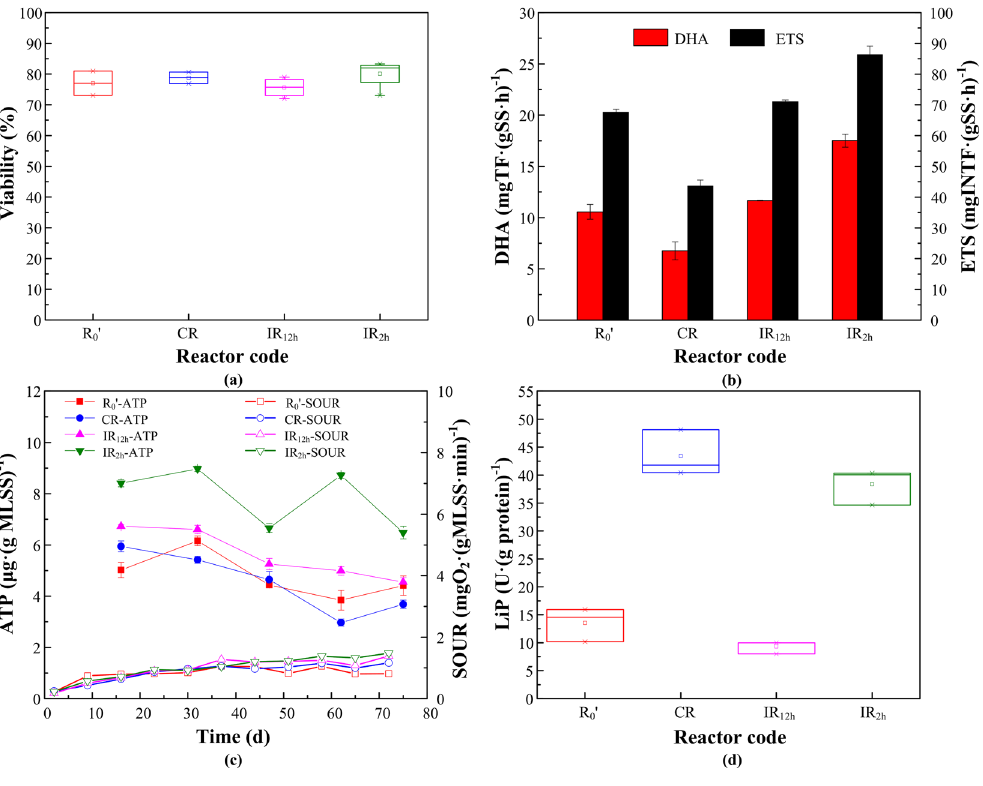
Figure 3. Physiological characteristics of activated sludge microorganism under different DC application modes. ( a ) Viability; ( b ) TTC-DHA and INT-ETS; ( c ) SOUR and ATP contents; ( d ) LiP activity.